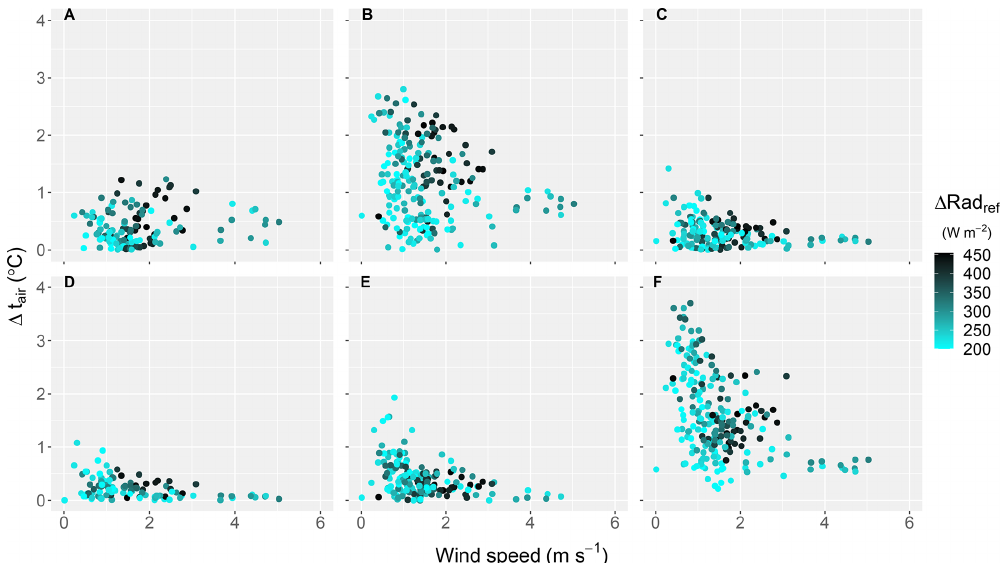
Figure 12. Temperature differences (cid:49)t air measured as a function of wind speed for all the instrument types (A–F). A cyan scale is used to show the value of the difference of reflected radiation, (cid:49) Rad ref , in relation to each value of (cid:49)t air